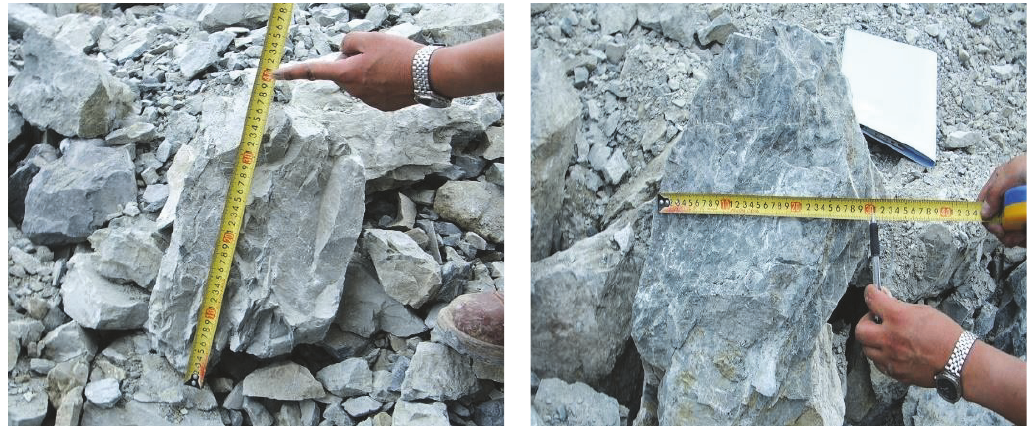
Figure 10: Shape of blasted rock with blasting